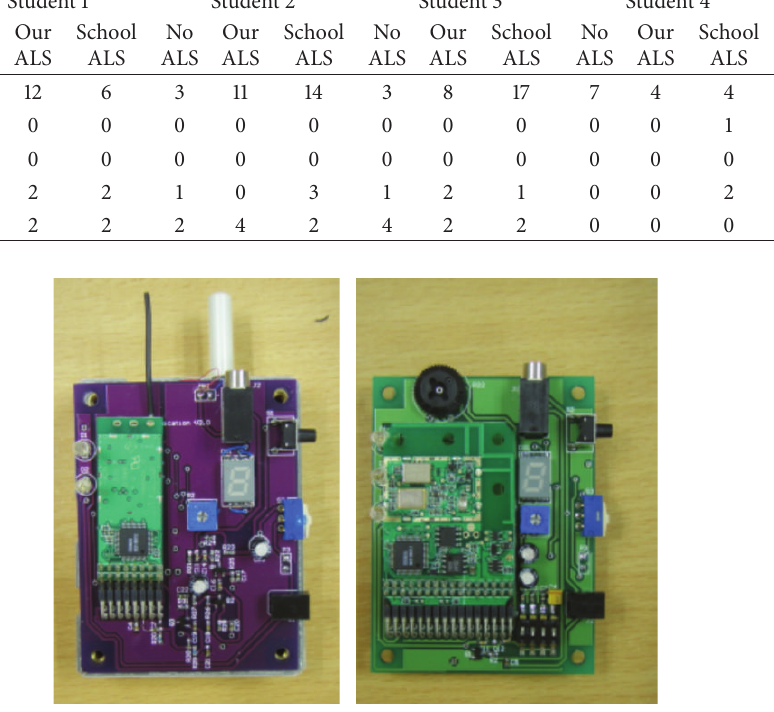
Figure 4: Transmitter and receiver PCBs.